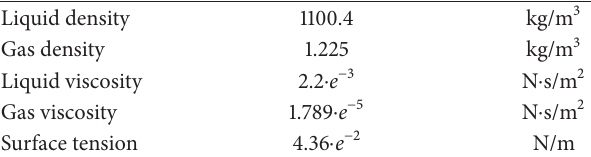
Table 2: Liquid and gas phase physical